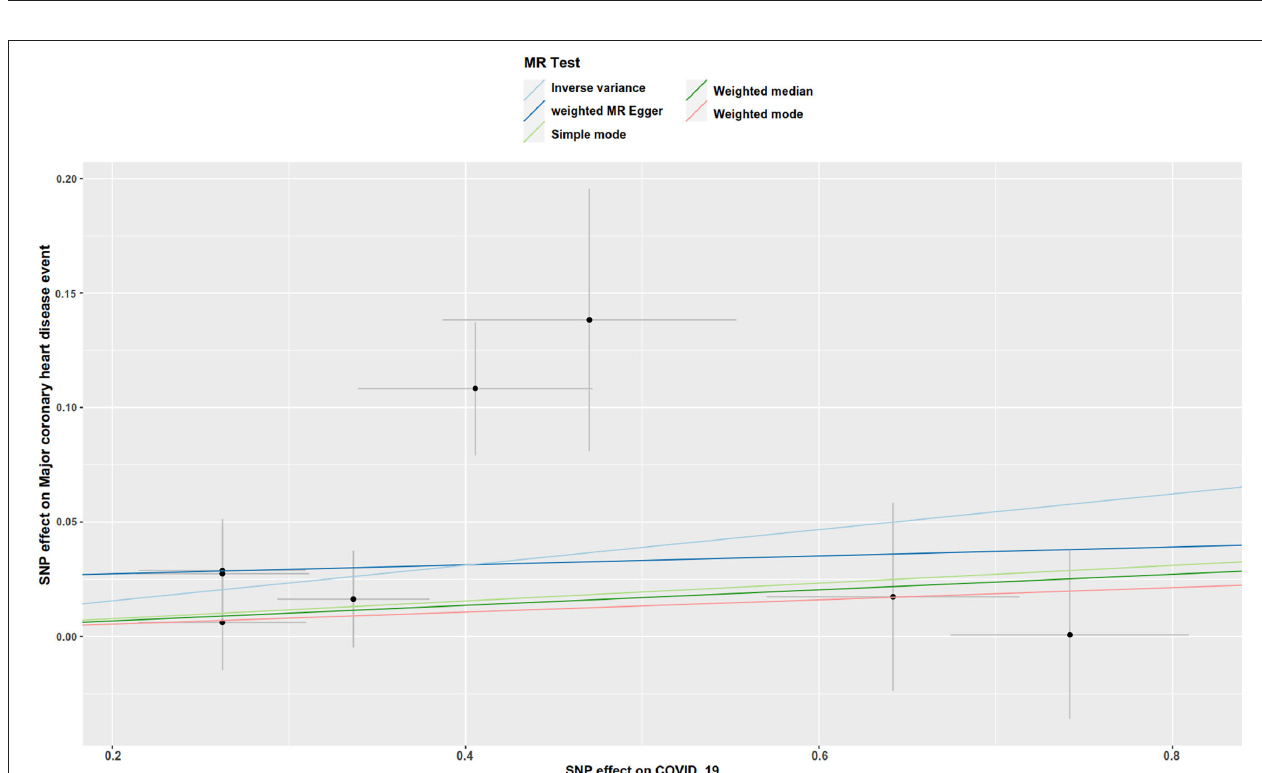
FIGURE 2 | Associations of genetically predicted COVID-19 with ten cardiovascular conditions in FinnGen project.